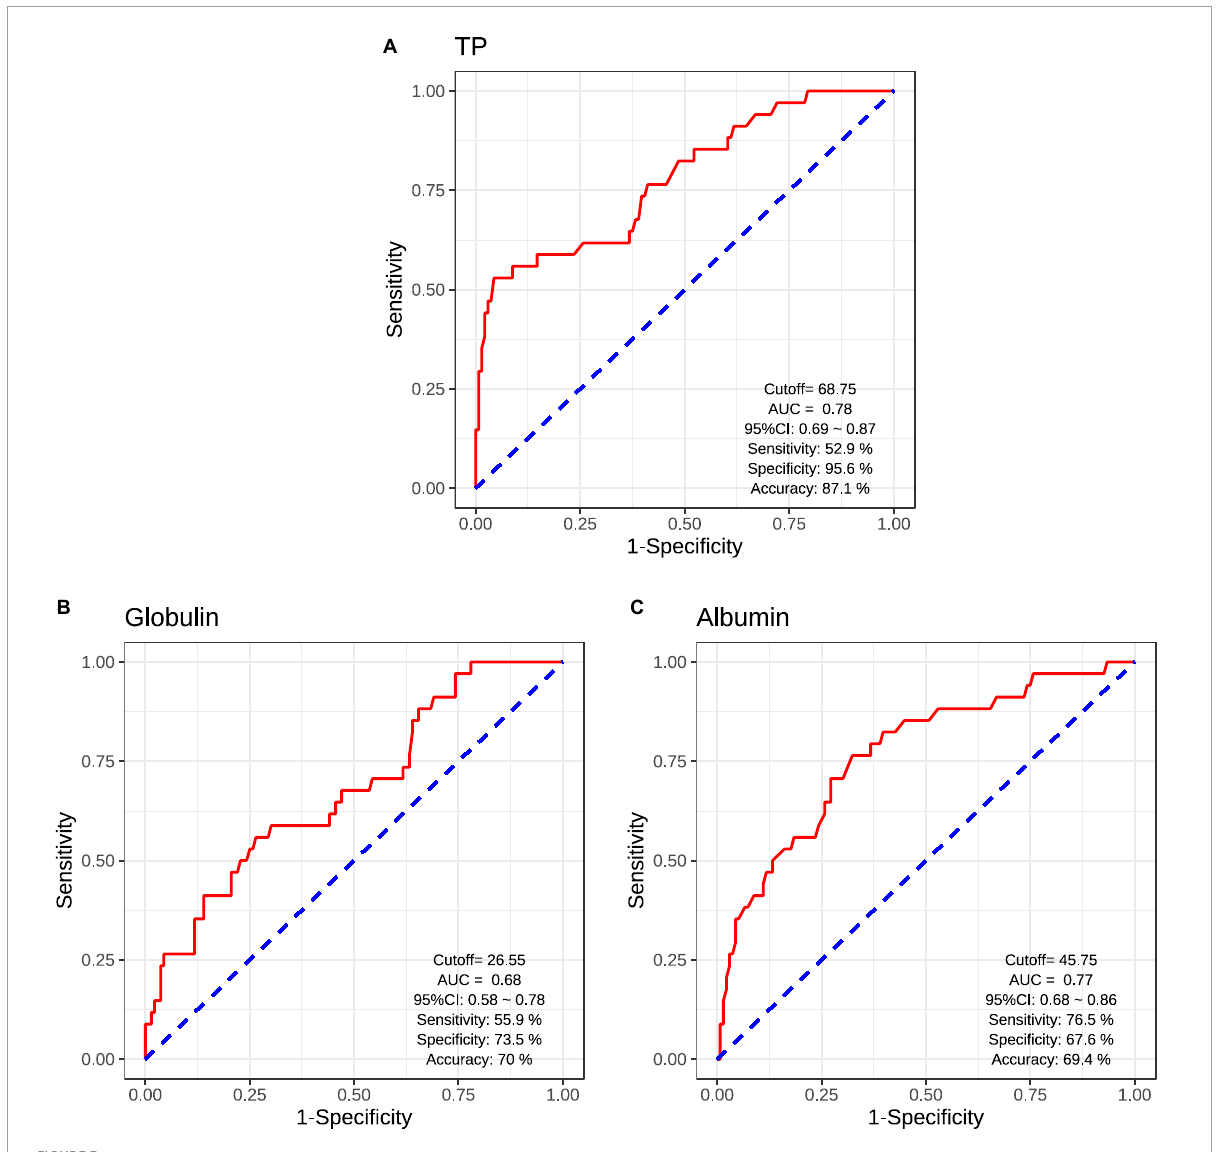
FIGURE3 Receiver operating characteristic (ROC) curves for the classification models were identified schizophrenic diagnosis based on serum TP levels (A) , serum globulin levels (B) , and serum albumin levels (C) . CI, confidence interval; AUC, area under